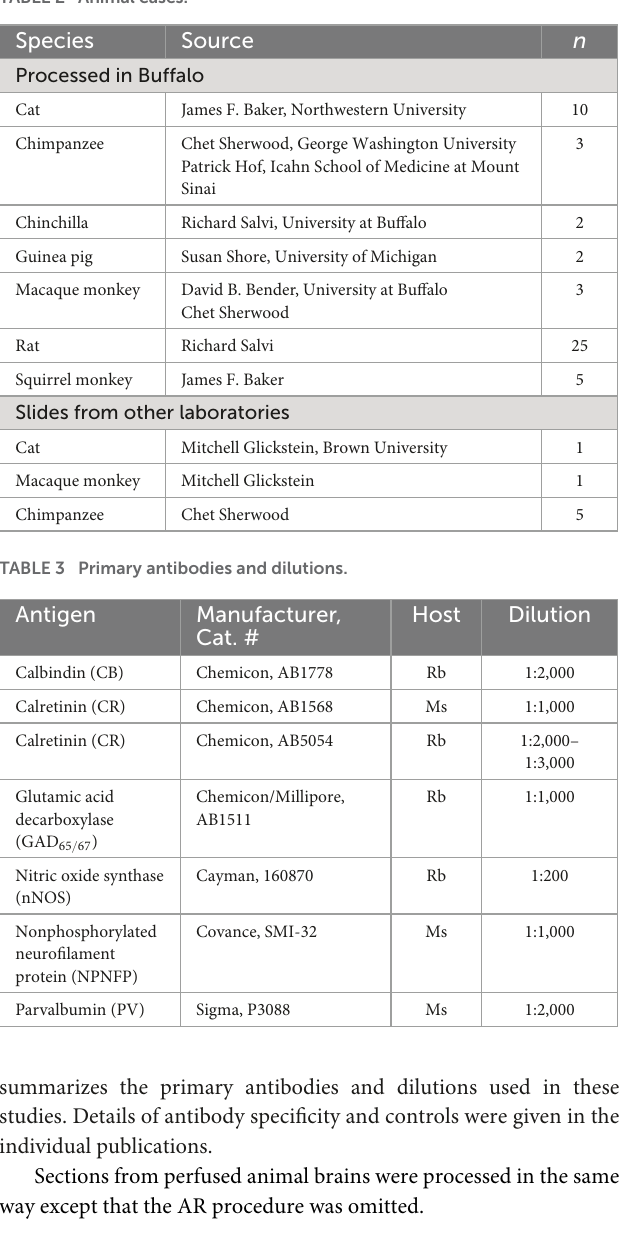
(CR Figure 1L ) and non-phosphorylated neurofilament protein (NPNFP, Figures 1C, K, L ) and not calbindin (CB, Figure 1H )